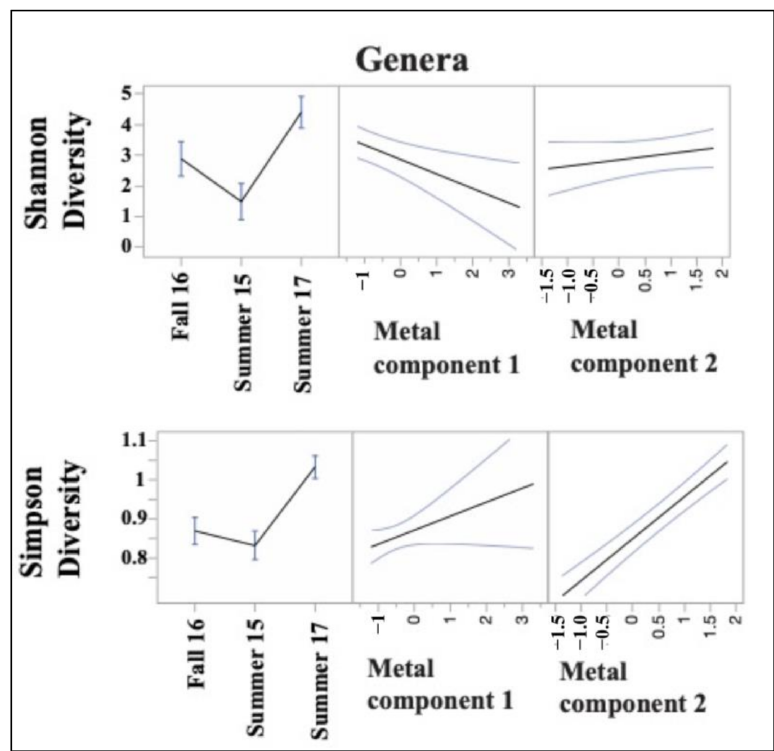
Figure 8. Prediction profiles from ANOVA showing the effect of metal component 1 and 2 (from principal component analysis) on the Shannon and Simpson diversity indices identified as taxonomic genera from wetland sites 1–6 during fall 2016 and summer 2015 and 2017. The blue-lined area in each profile represents the 95% prediction confidence interval of the response variable. The profiler was set to metal component 1 at 0.65 and metal component 2 was set to 0.18 in the case of both Shannon diversity and Simpson diversity.